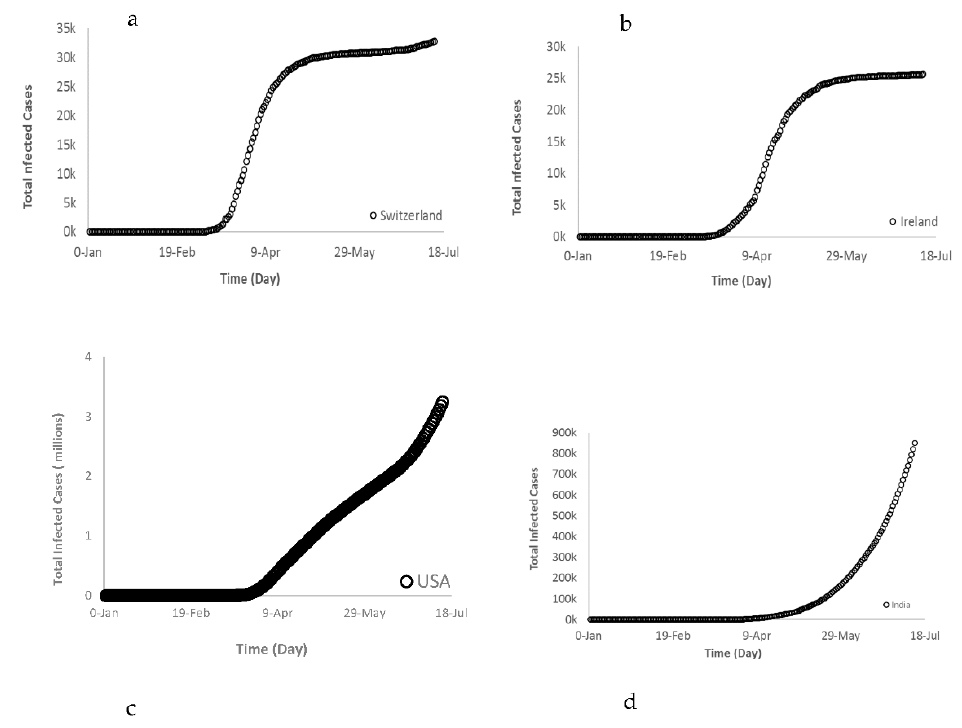
Figure 4. ( a ) Switzerland and ( b ) Ireland as examples of Group A, and ( c ) USA and ( d ) India as examples of Group B.